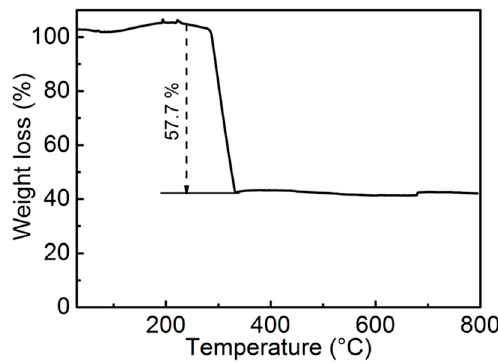
Figure 1. TG curve of the precursor MnFe-based oxalate.